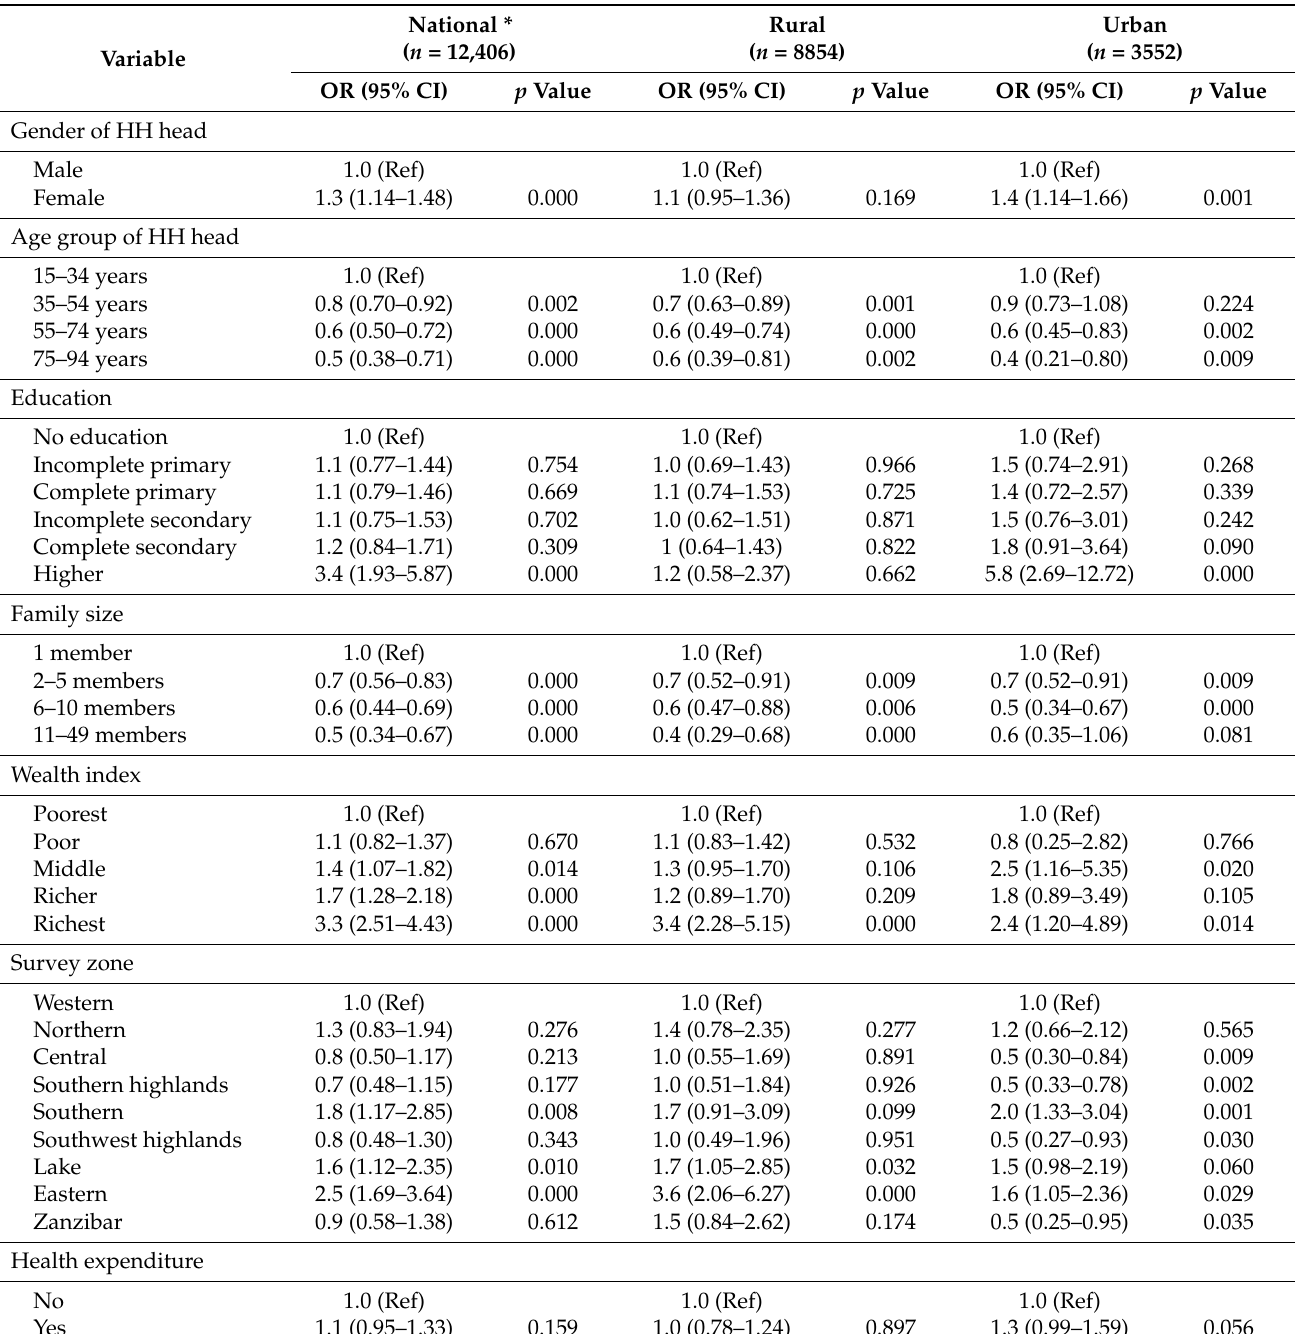
Table 3. Social and spatial predictors of household smoke-exposure risks (SERs) in